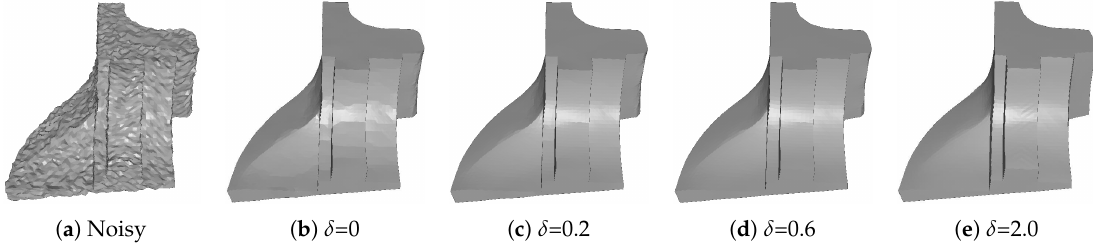
Figure 4. Denoising results for different δ with fixed other parameters ( α , β , and γ ). From left to right: input noisy mesh (corrupted by Gaussian noise with standard deviation σ = 0.2 mean edge length) and results with different δ